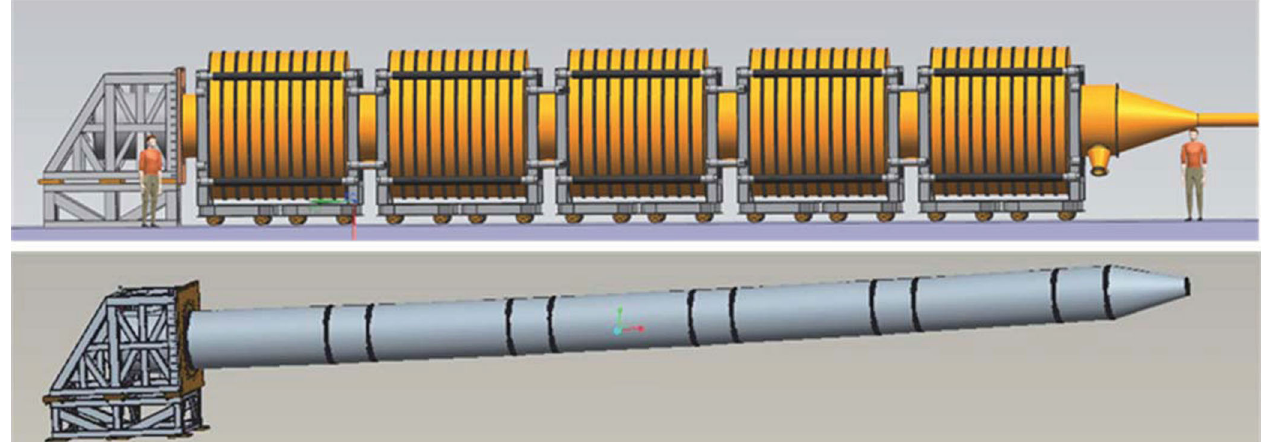
FIG. 8. Schematic of M-50 and the inner stalk of the IVA. The 50 LTD cavities are divided into five groups. Each group has independent fixing structure. The lower picture shows the inner stalk of the IVA, which is fixed to the base shelf at the left and kept free of support at the other